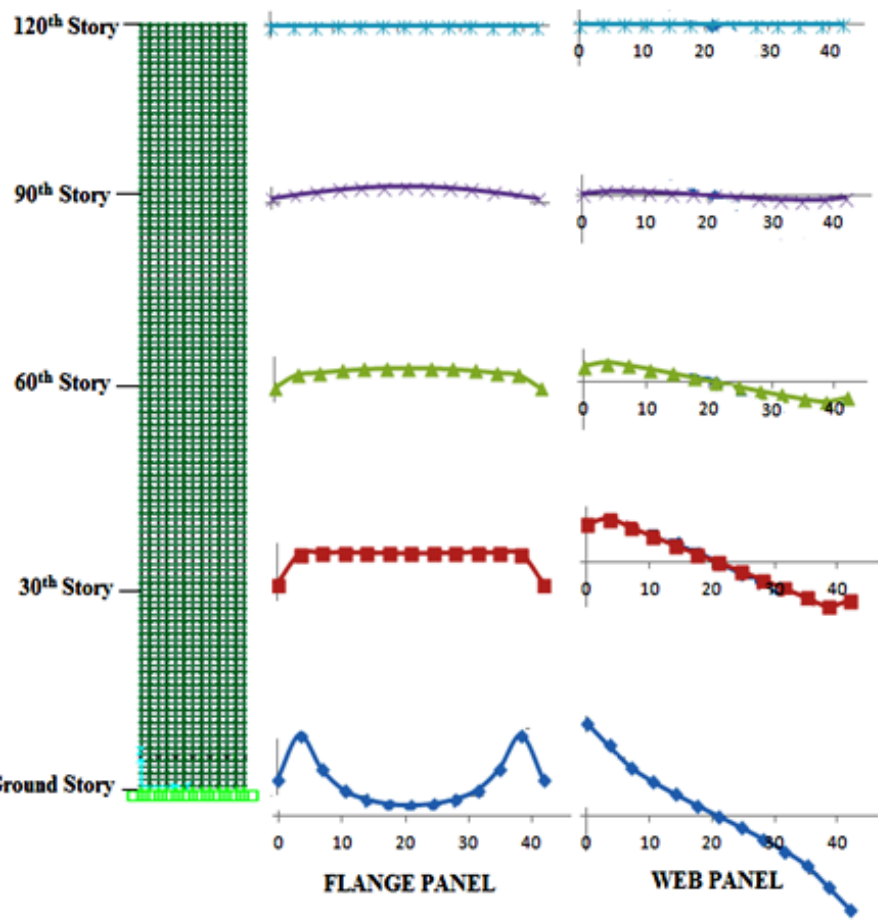
Figure 6. Shear lag effect in 120-story high building. Flange and web panel are